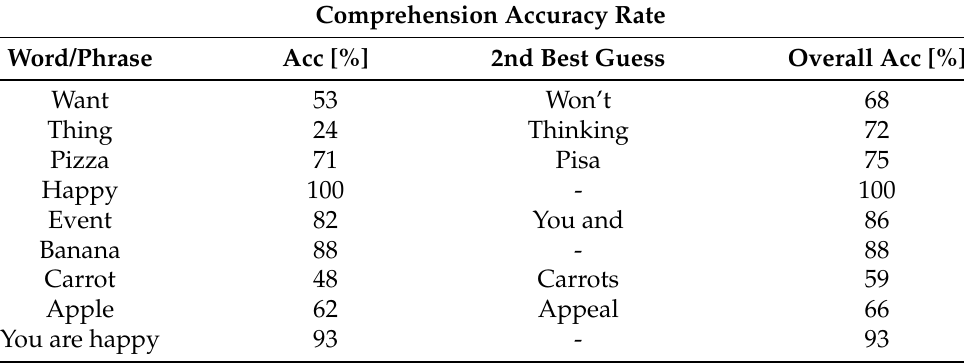
Table 2. Comprehension accuracy rate